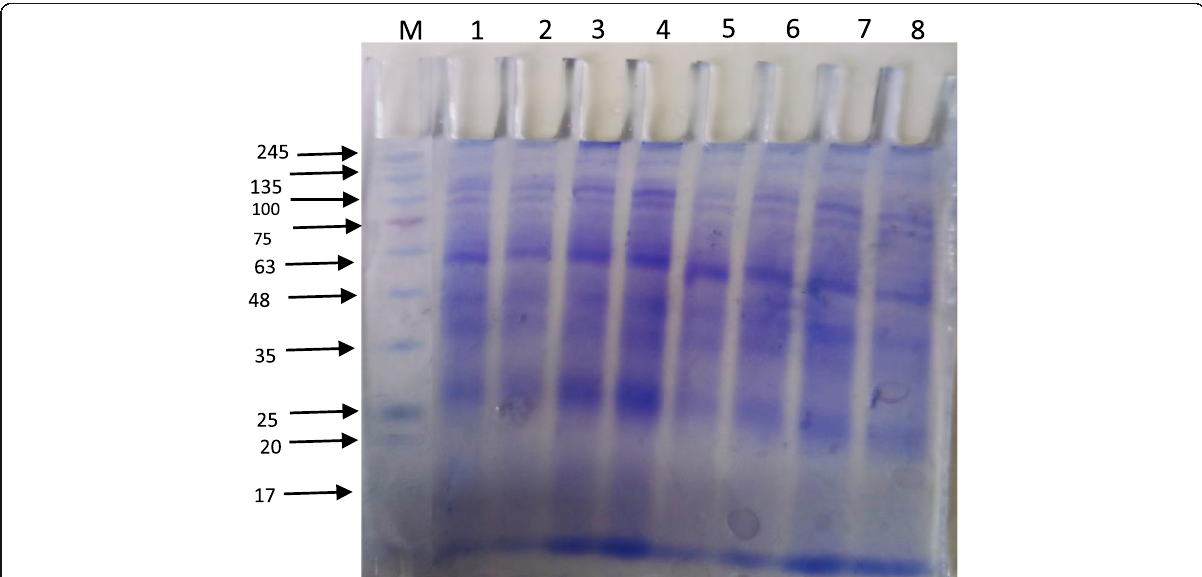
Fig. 2 SDS-PAGE of protein extracted from G1 and G2 cultivars under control and treatment with different EMS doses. M marker, lane 1 = G1 (control), lane 2 = G1 (0.1 EMS), lane 3 = G1 (0.2 EMS), lane 4 = G1 (0.3 EMS), lane 5 = G2 (control), and lanes 6, 7, and 8 for G2 with 0.1, 0.2, and 0.3 EMS dose,